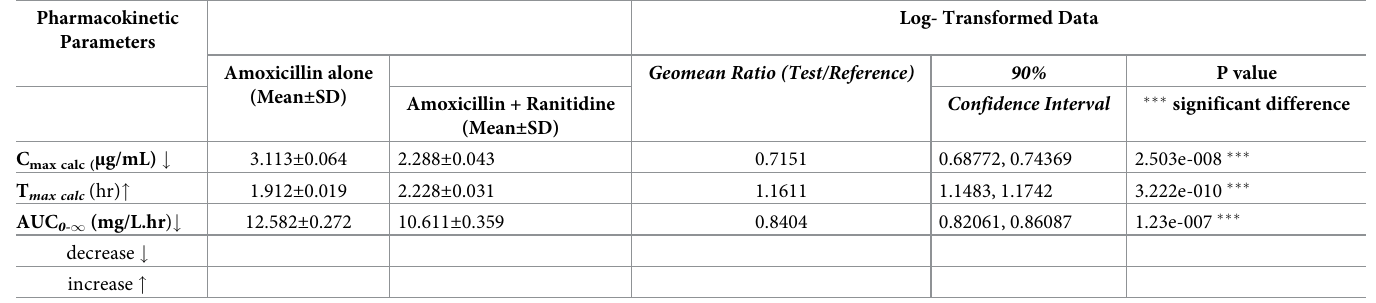
Table 3. Statistical assessment of amoxicillin pharmacokinetic interaction with ranitidine. Pharmacokinetic